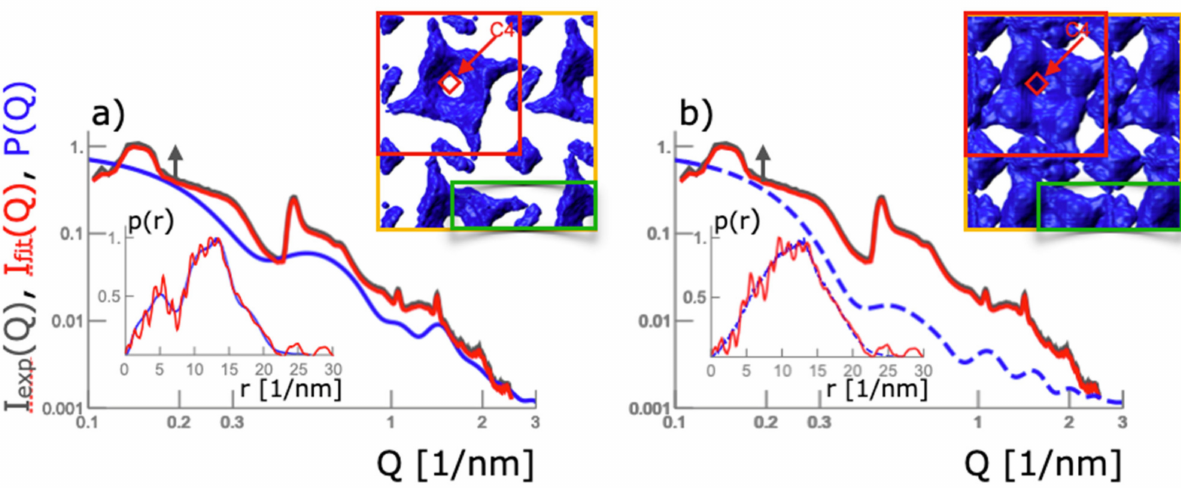
Figure 2. Experimental scattering data, the corresponding pair densities, hull and core models. ( a , b ) grey lines, I exp (Q) resemble experimental scattering data of a native SbpA S-layer. Red lines, I fit (Q) mark best fits. For better visibility, grey lines (raw data) were shifted a little. The corresponding pair densities, p(r), are given by red lines in the inserts. Solid blue and dashed blue lines, P(Q), indicate form factors calculated from the core and hull model via their pair density, p(r), shown in the